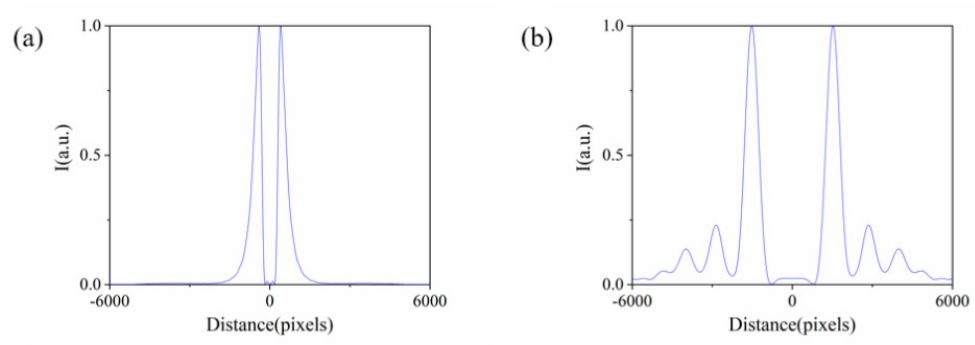
Figure 3. The normalized intensity distributions along the red line ( a ) in Figure 2e, and ( b ) in Figure 2f.